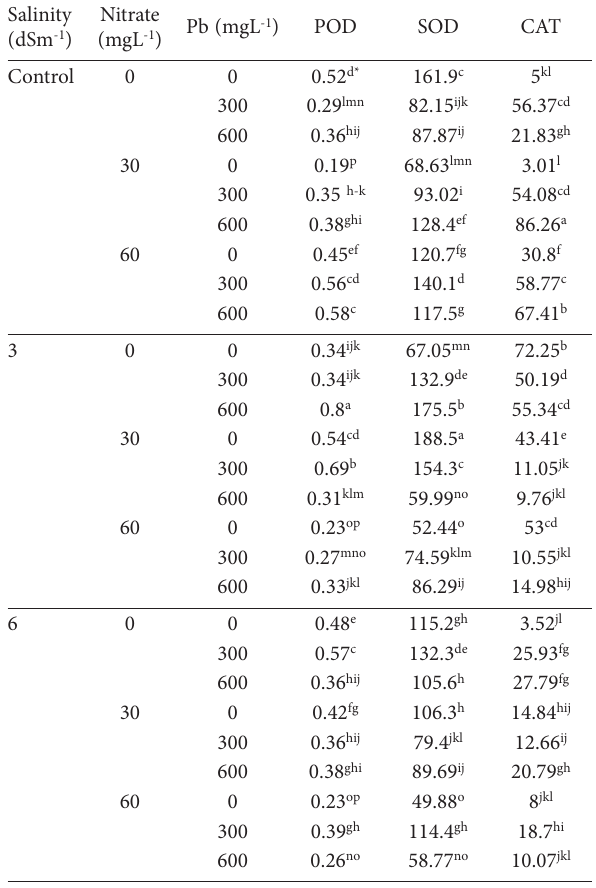
Table 1. Activities of antioxidant enzyme in response to treatments. Salinity (dSm -1